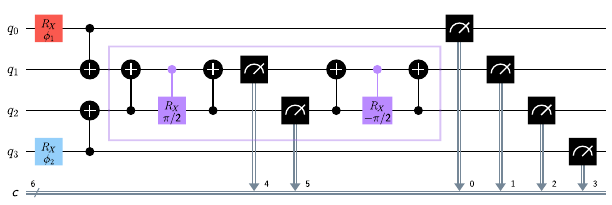
FIG. 12. Quantum-circuit implementation of the quantum- measurement-cooling heat-engine design. The main qubits q 1 , q 2 are first prepared in thermal states at different temperatures with the aid of their ancillas q 0 , q 3 and then undergo a measurement in the singlet-triplet basis, Eq. (37), purple box. Finally, their ini- tial states are read off the ancillas, and their final states are read directly. The outcome of the singlet-triplet basis measurement is discarded.